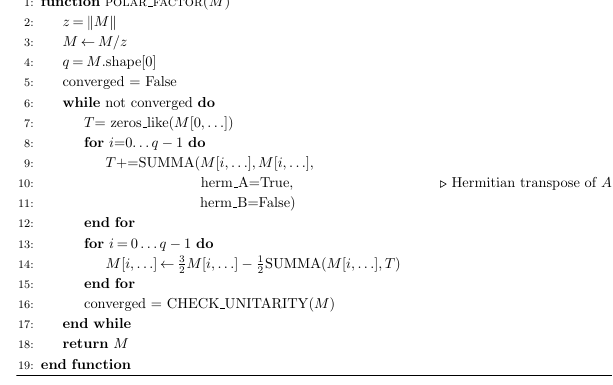
Algorithm 2. Newton-Schultz iteration for the polar factor of